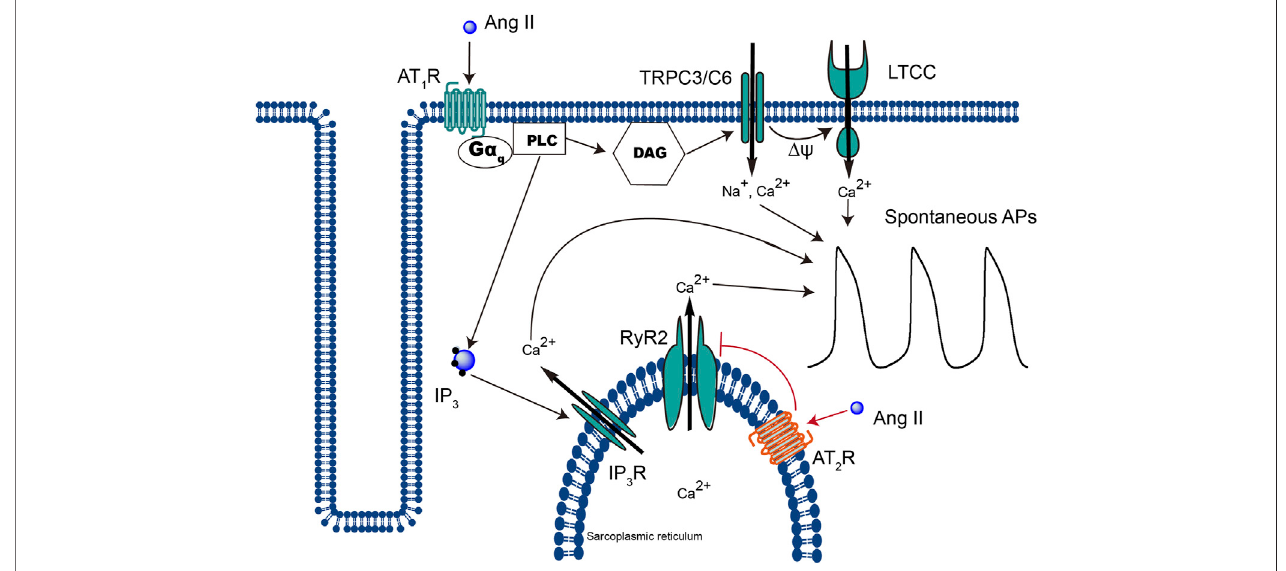
FIGURE7| Schematicrepresentation ofthe differentsignaling pathways that extracellular Ang IIand iAngIIutilize toregulatetheautomaticity ofCMs. Extracellular Ang II, upon binding to AT 1 R, leads to the production of DAG and IP 3 , which open TRPC3/C6 and subsequently LTCC and IP 3 R, respectively, and increases the automaticity of CMs. On the other hand, binding of iAng II to AT 2 R decreases the automaticity of CMs by reducing the activity of